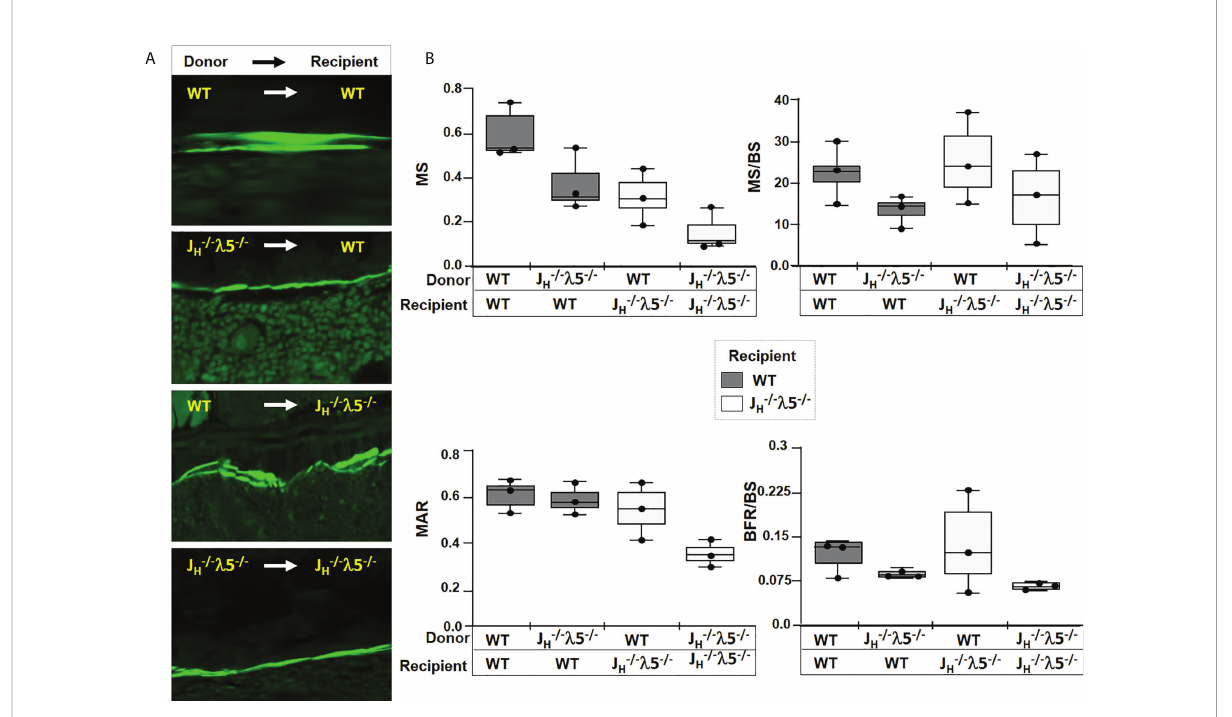
FIGURE 6 Dynamic bone synthesis upon adoptive transfer of l 5-suf fi cient bone marrow cells. (A) Representative images of calcein labelled new bone synthesis in irradiated mice reconstituted with bone marrow from the indicated genotypes. Femur endosteal surfaces were analyzed 6-months after reconstitution. (B) Quanti fi cation of mineralized surface (MS), ratio of mineralized surface over bone surface (MS/BS), mineral apposition rate (MAR), and bone formation rate over bone surface (BFR/BS). The genotypes of the donor and the recipient mice are indicated. Data were obtained from n=3-5 mice per group. The experimental data are the average of three repeats. Statistical signi fi cance was calculated by